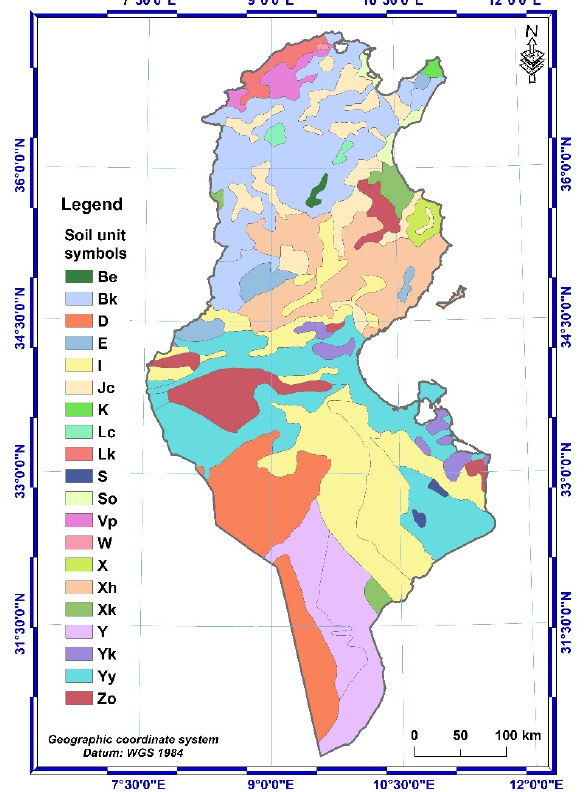
Figure 8. Soil map of Tunisia (extracted from the FAO-UNESCO Soil Map of the World).